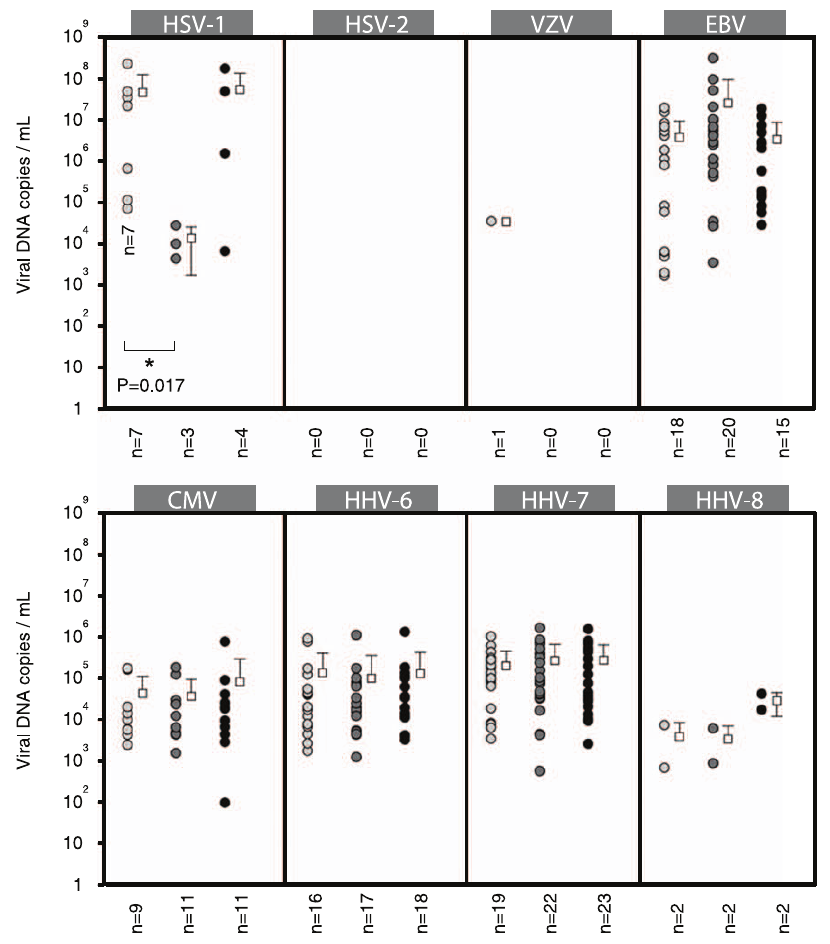
Figure 3. Salivary shedding of HHVs before and after anti-malarial treatment. Quantitative comparison of HHVs loads (viral DNA copies/ mL) during salivary shedding in children with acute malaria before (M + day-0; light gray circles) and after (M + day-14; dark gray circles) anti-malarial treatment and in children having mild infections unrelated to malaria (M 2 ; black circles). Each white circle represents the viral load for a select HHV for one patient. White squares depict the mean values, with standard deviations. For a select HHV, only samples with detectable viral DNA, reflecting salivary shedding, were considered for this analysis (n=number of samples analyzed).